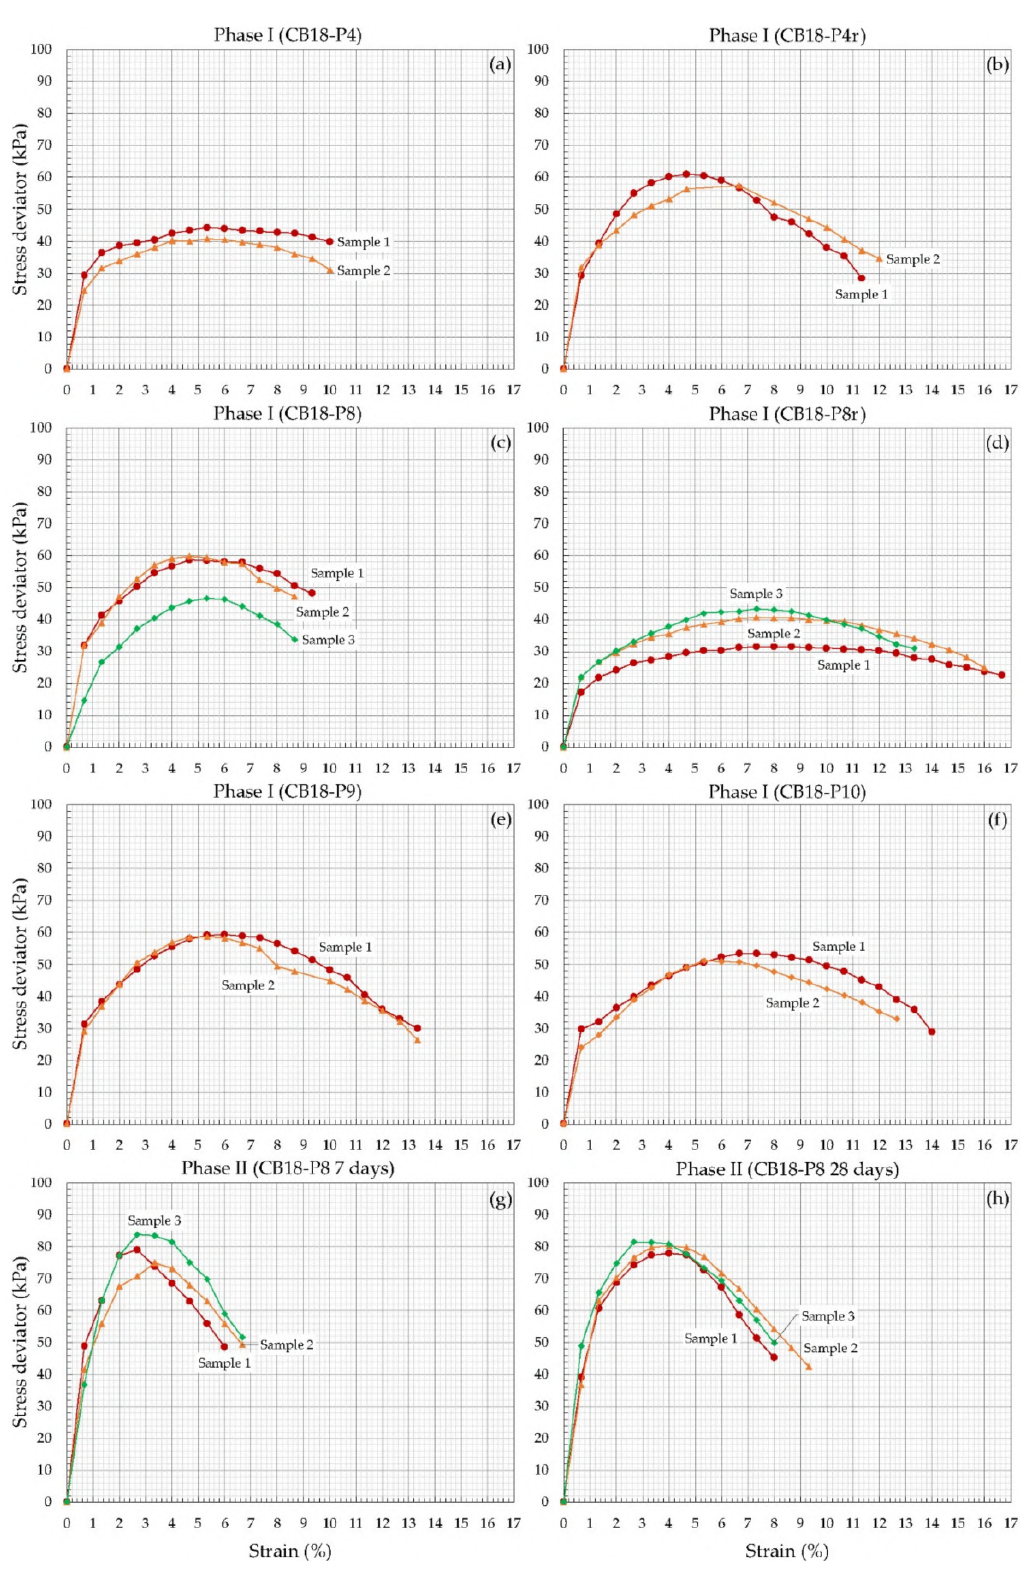
Figure A1. Results of the Simple Compression tests. ( a – f ) Phase I; ( g – h ) Phase